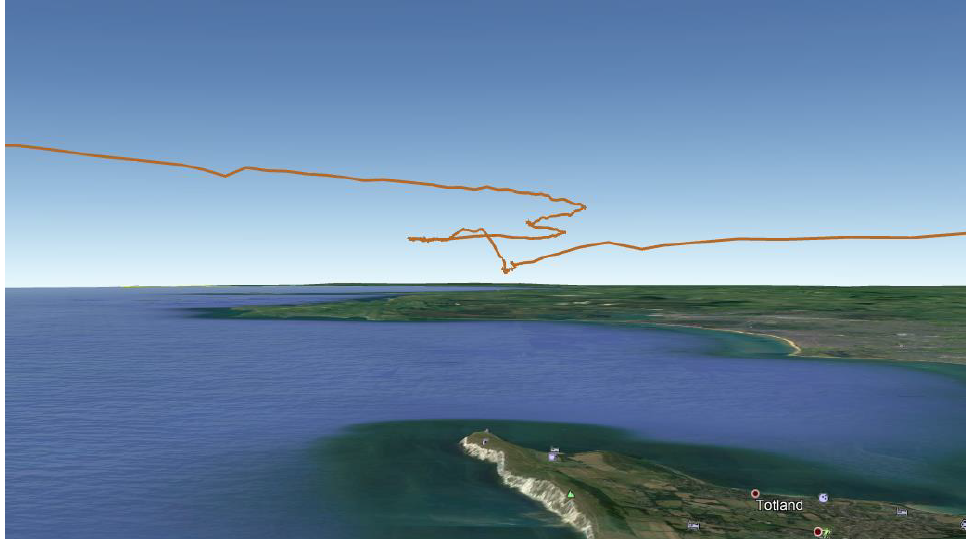
Figure 17. A screenshot showing a view which shows the trail of the aircraft’s altitude